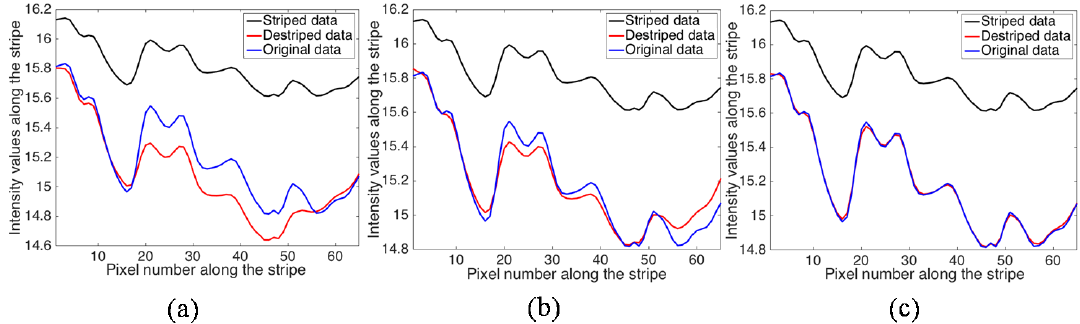
Figure 3. This figure presents three different reconstructions of the stripe at the 110th row of the image shown in Fig. 1b. The graphs show the actual data in blue, striped data in black and the destriped data in red. Graphs (a) and (b) represent the reconstructions from the functional in Eq. (3) with α = 1 and α = 3 × 10 − 1 , respectively. The graph (c) shows the reconstruction from the functional in Eq. (6) with α = 7 × 10 − 1 .